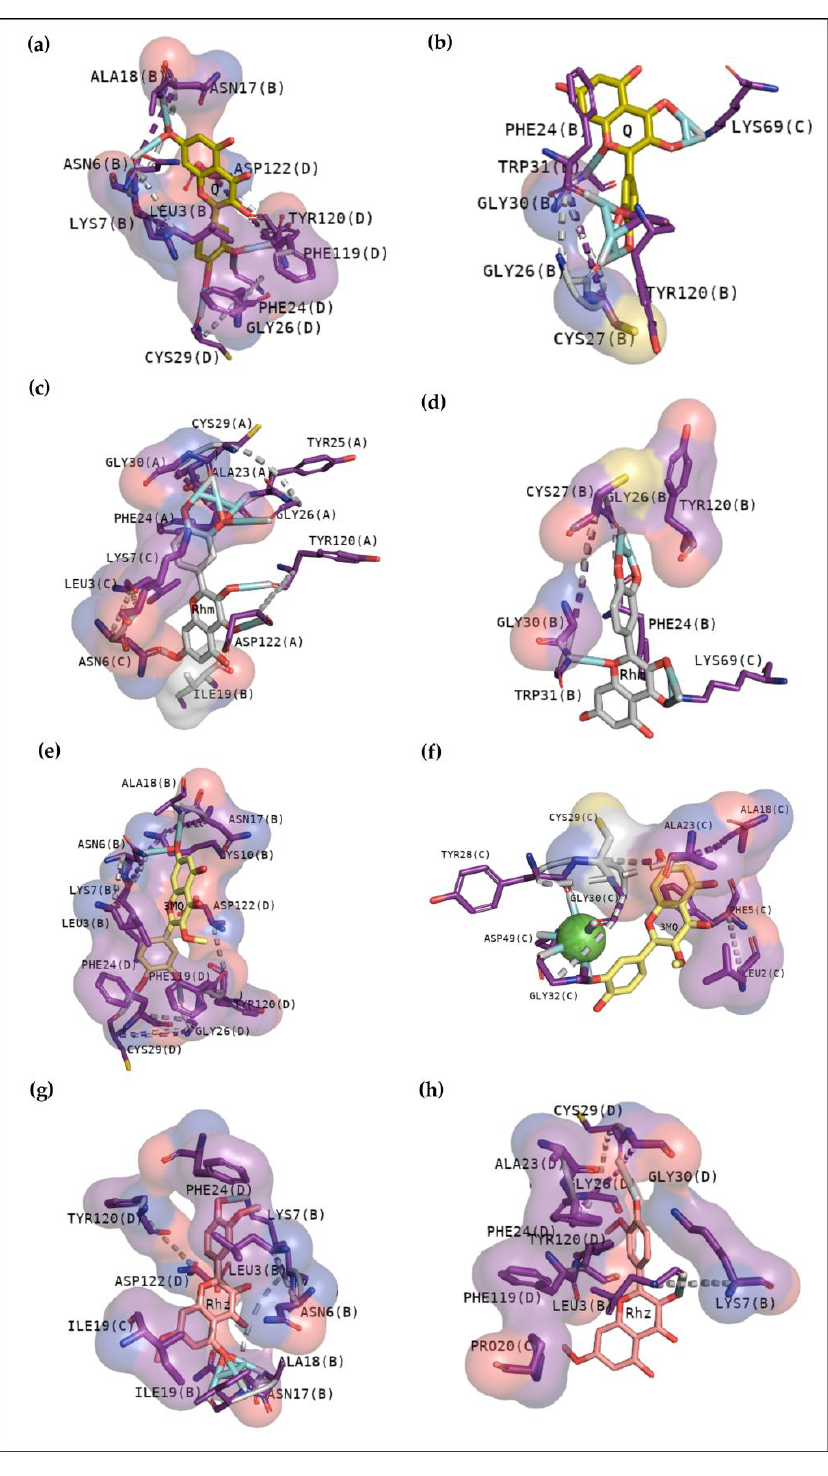
Figure 8. Docking results of CdtsPLA2 with Quercetin derivatives. ( a ) First cluster of Q revealing interactions between chain B and D, and the second, between B and C ( b ). Chain A, B and C were involved in the first Rhm anchoring with the protein ( c ), however, just B and C were observed in the second ( d ). Differently, with a high number of hydrophobic contacts, the first cluster of 3MQ anchors between chains B and D ( e ), and the second one fits in the protein active site ( f ). Similar residues are involved in the Rhz-CdtsPLA2 anchoring, with hydrophobic contacts in the first ( g ) and second cluster ( h